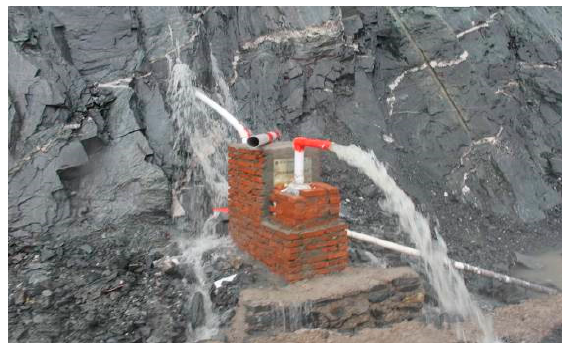
Figure 11. Pipe draining of rainwater and groundwater away from Nanfen open-pit mine slope.